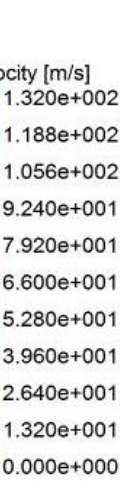
Fig. 8. Flow fields for a tube with baffles at different pitch ratio, Re